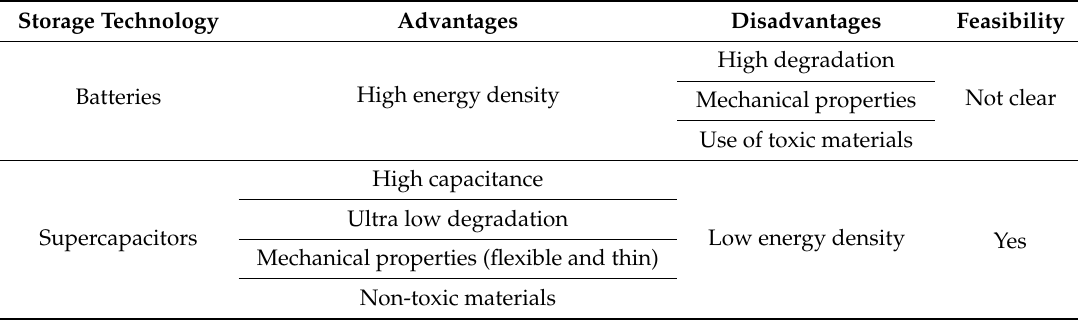
Table 4. Comparison among storing